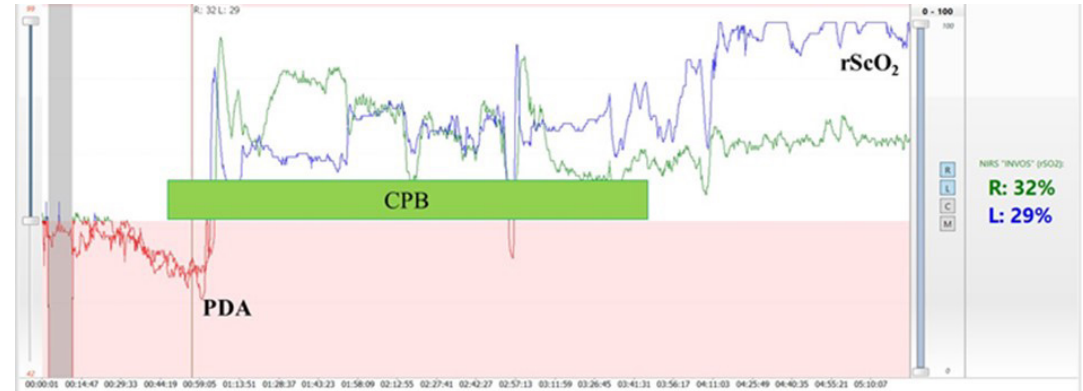
Fig. 2 - Neonate cerebral/somatic regional oximetry (rScO2/rSsO2). Recovery of the desaturation after interruption of the pulmonary runoff by patent ductus arteriosus (PDA) closure during a Jatene surgery. The rScO2 behaviors at the end of the surgery might indicate an increase in the cerebral blood flow due to cerebrovascular autoregulation disruption and increase in blood pressure. CPB=cardiopulmonary bypass; rScO2=regional cerebral